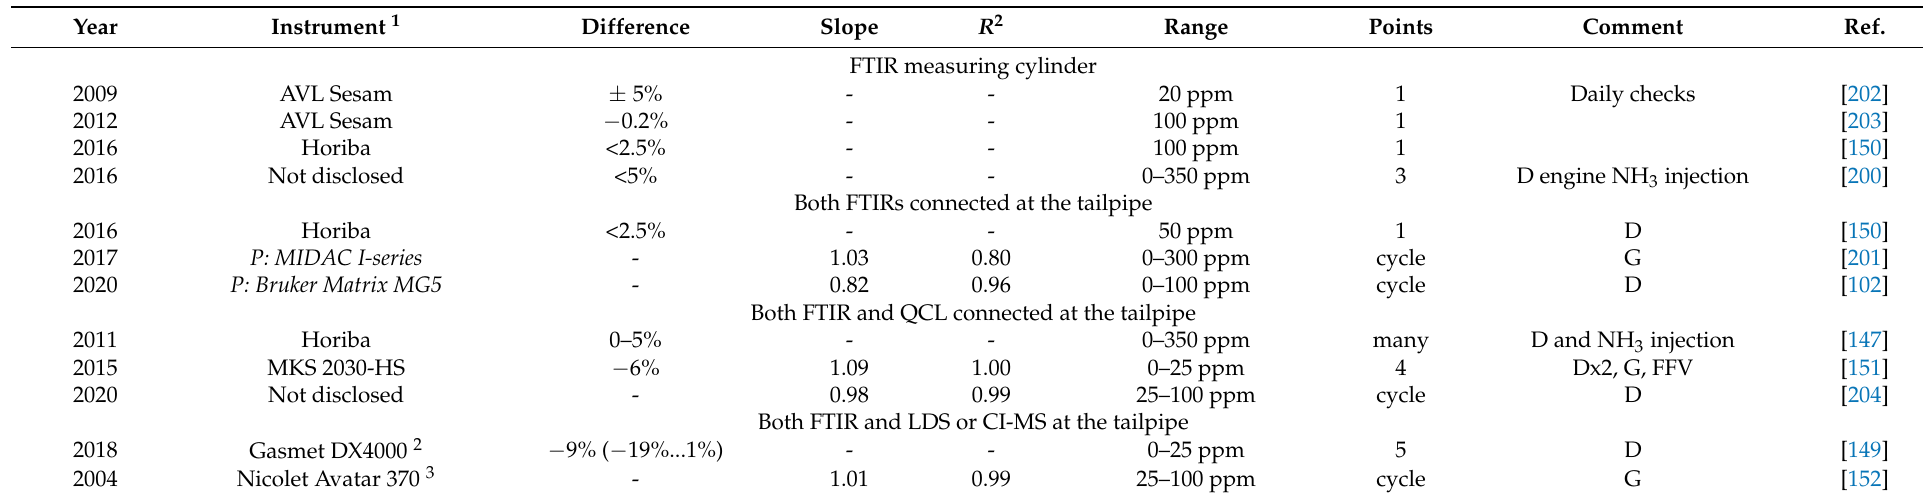
Table A4. Comparisons of FTIR with NH 3 analyzers (FTIR, QCL,